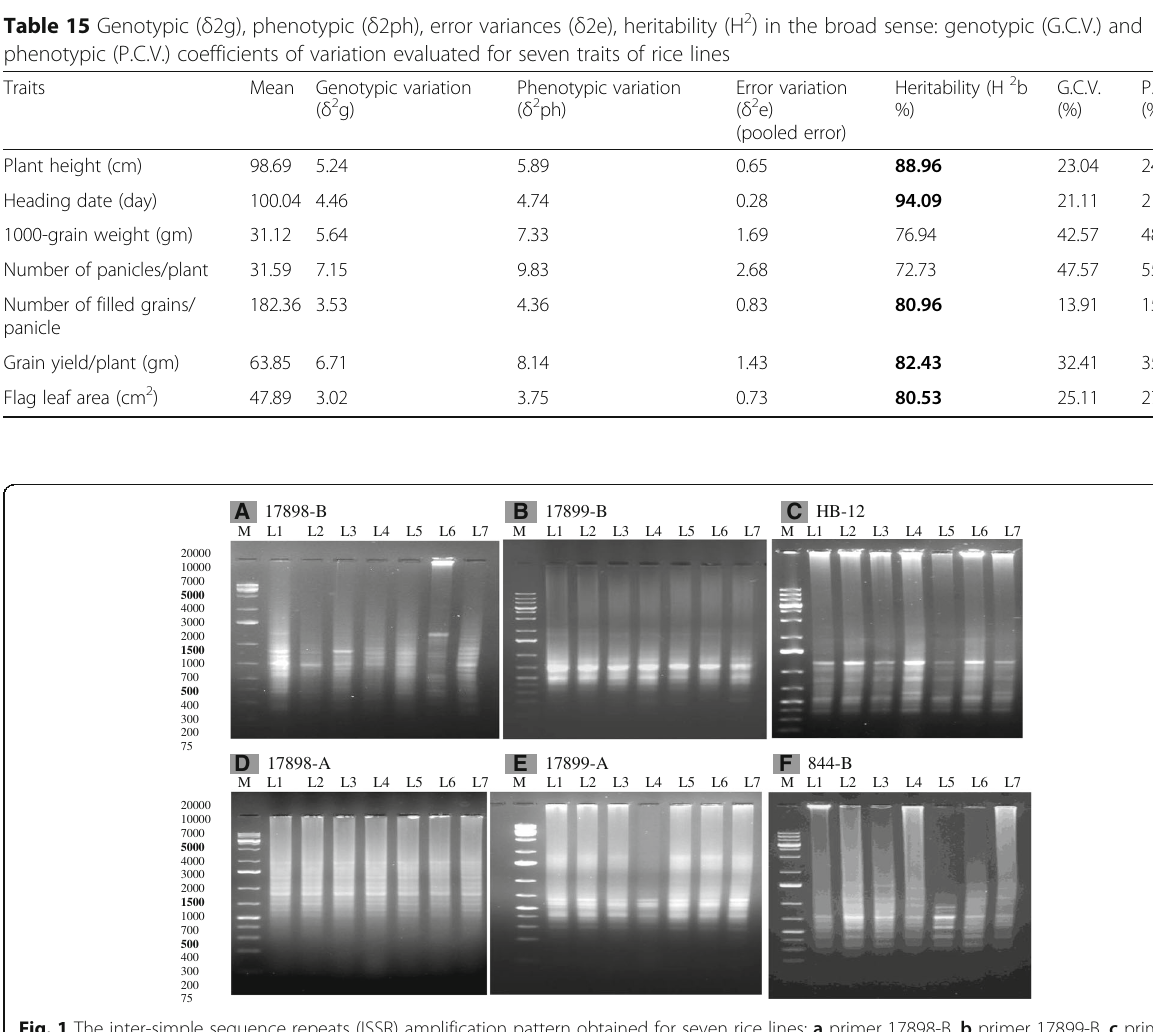
Fig. 1 The inter-simple sequence repeats (ISSR) amplification pattern obtained for seven rice lines: a primer 17898-B, b primer 17899-B, c primer